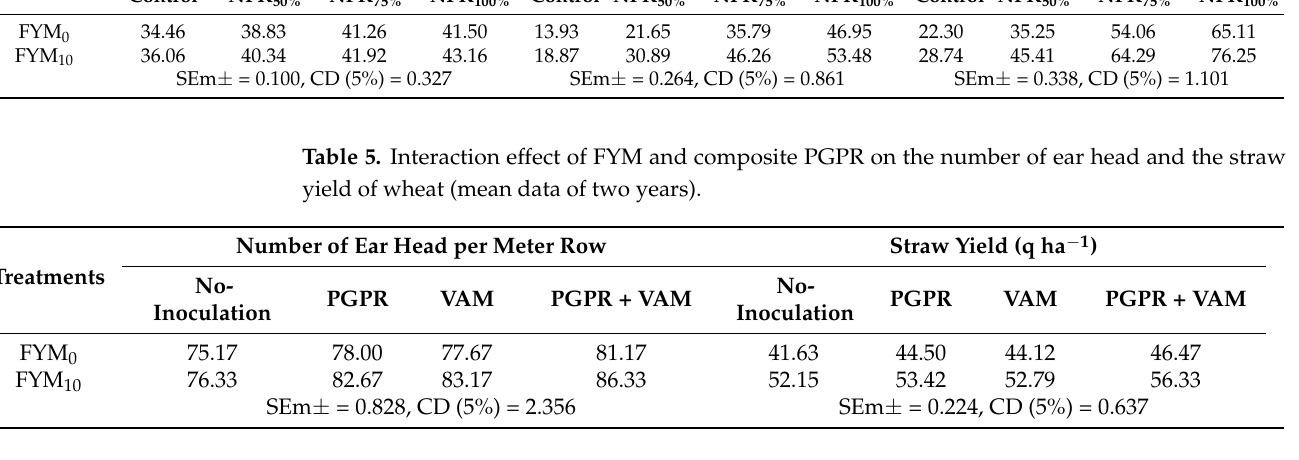
Table 6. Interaction effect of fertility levels and composite PGPR on the grain and straw yield (q ha − 1 ) of wheat (mean data of two years).